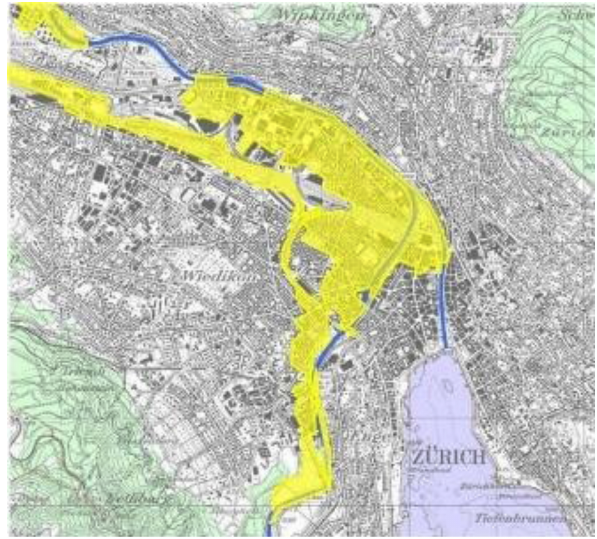
Figure 1. Hazard map of the city of Zurich ( © WWEA: Office of Waste, Water, Energy and Air, Canton of